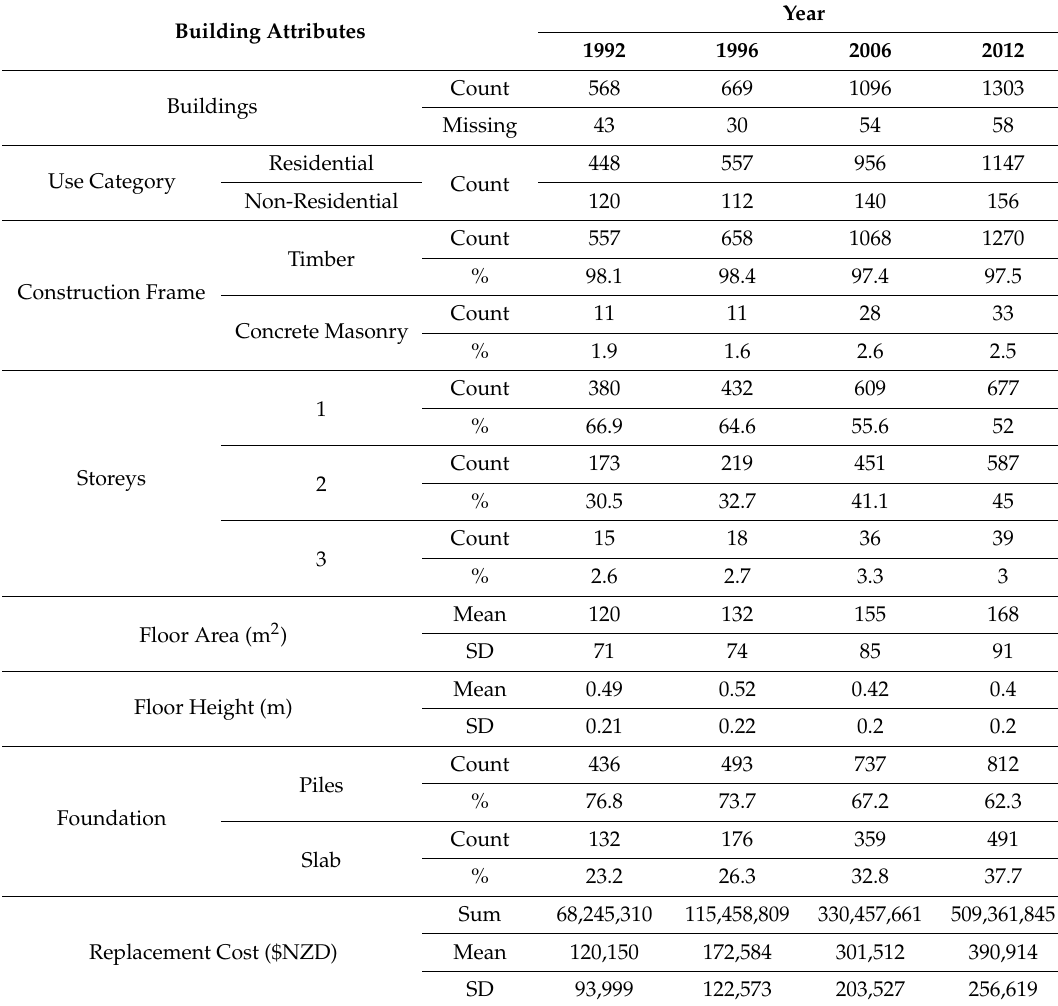
Table 1. Statistics relating to building attribute for the Omaha Beach urban settlement in each study